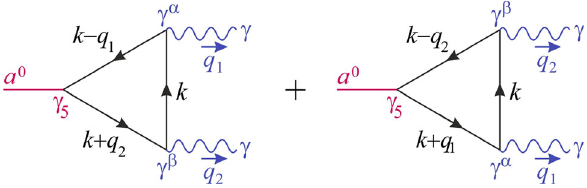
Fig. 1 Triangle graphs inducing the a 0 → γγ